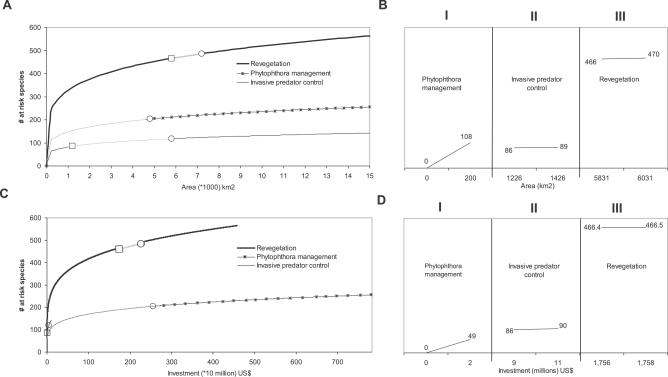
Species–Area Curves and Species–Investment Curves for Three Conservation ActionsThe three actions portrayed are Phytophthora management, invasive predator control, and revegetation in the Swan Coastal Plain scrub and woodlands ecoregion of Australia. In (A) and (C), the area of conservation interest is illustrated by the curve to the left of the circles, comprising the area already receiving the action (denoted by the solid lines between the origin and the squares) and the area requiring the action (denoted by the dashed lines between the squares and the circles). Three categories of species are represented within the tail of the curves, beyond the area of conservation interest (that is, to the right of the circles). The species within these categories are not necessarily mutually exclusive. The first contains at risk species whose populations also occur in habitat outside the area of conservation interest for a particular threat. These species do not rely fully on the conservation action to persist in the ecoregion. The second category also reflects the uncertainty about the distributions of species, as these species do not actually occur within the area of conservation interest. The third category represents part of the extinction debt due to past habitat loss and contains at risk species that are unlikely to persist in the ecoregion over the long term, regardless of the conservation action. The number of species in each of the three groups cannot be determined in this example, since our method of estimating biodiversity benefit does not allow the individual species or their geographic distributions to be identified (Text S2).(A) Species–area curves.(B) The number of at risk species protected after an additional investment of 200 km2 in each conservation action (the panels are close-ups of the curves in [A] and represent the benefit of the additional investment from the area already receiving the action).(C) Species–investment curves, where the area invested in each action is replaced by the cost of the ecoaction.(D) The number of at risk species protected before and after an additional investment of US$2 million in each conservation action (the panels are close-ups of the curves in [C] and represent the benefit of the additional investment in the area already receiving the action).